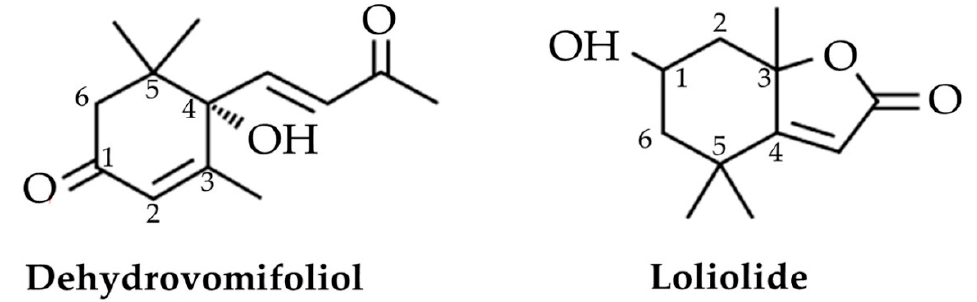
Figure 4. The chemical structures of the isolated allelopathic compounds dehydrovomifoliol and loliolide from the extracts of Albizia